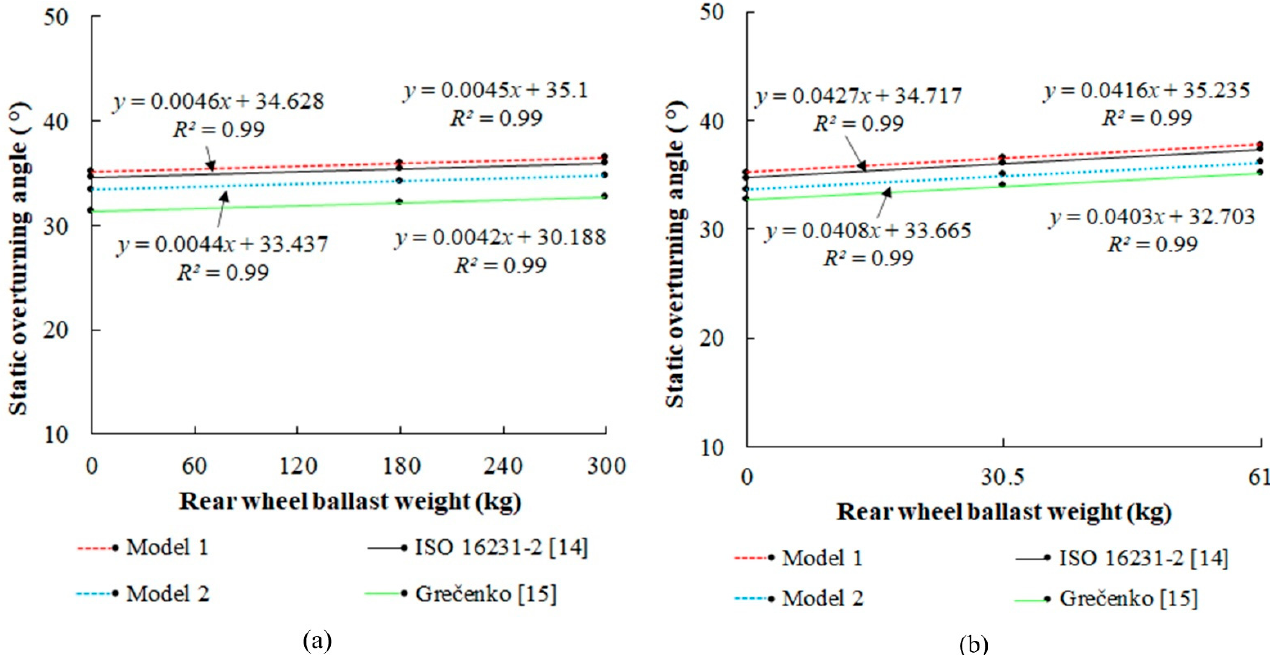
Figure 10. Comparison of [14,15], Model 1, and Model 2 at low overall tire width: ( a ) Universal tractor; ( b ) Subcompact tractor.